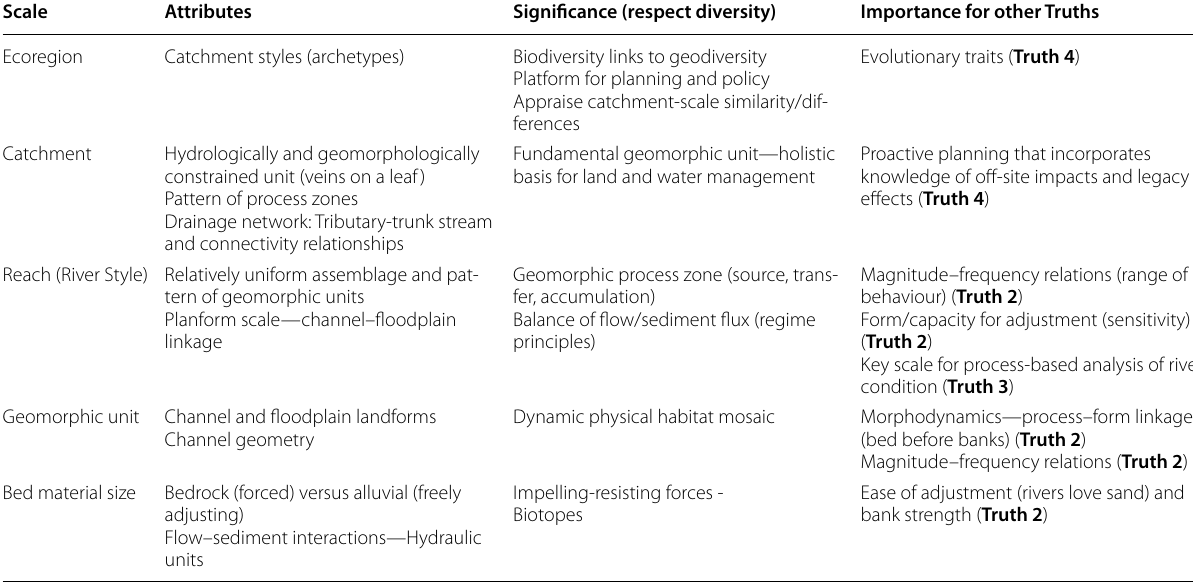
Table 2 Geomorphic principles that underpin management practices that respect diversity ( Truth 1 ) Work with the river as it is, not theoretical or digital representations of a river divorced from place-based understandings Geography and history matter. Theory is good, but reality is better Open-ended and flexible practices identify and look after key values of each and every river Some rivers are inherently messy (heterogeneous), others are not. Some rivers are leaky, others are not. Not all rivers have a channel A nested hierarchical framework of understanding derives and applies appropriately contextualised, cross-scalar, catchment-specific knowledge Know your catchment. The catchment is the fundamental geomorphic unit. Like the veins on a leaf, the catchment feeds the river. What happens upstream impacts downstream—it’s just a matter of time Different types of river at the reach scale comprise differing assemblages of geomorphic units (also called hydromorphic or morphologic units) Drainage network configuration and tributary-trunk stream interactions influence the pattern of geomorphic process zones, associated patterns of river types and (dis)connectivity relationships at the catchment scale Listen to the river and learn from it. Catchment-specific understandings give due regard for diversity, variability, process, pattern and evolutionary traits